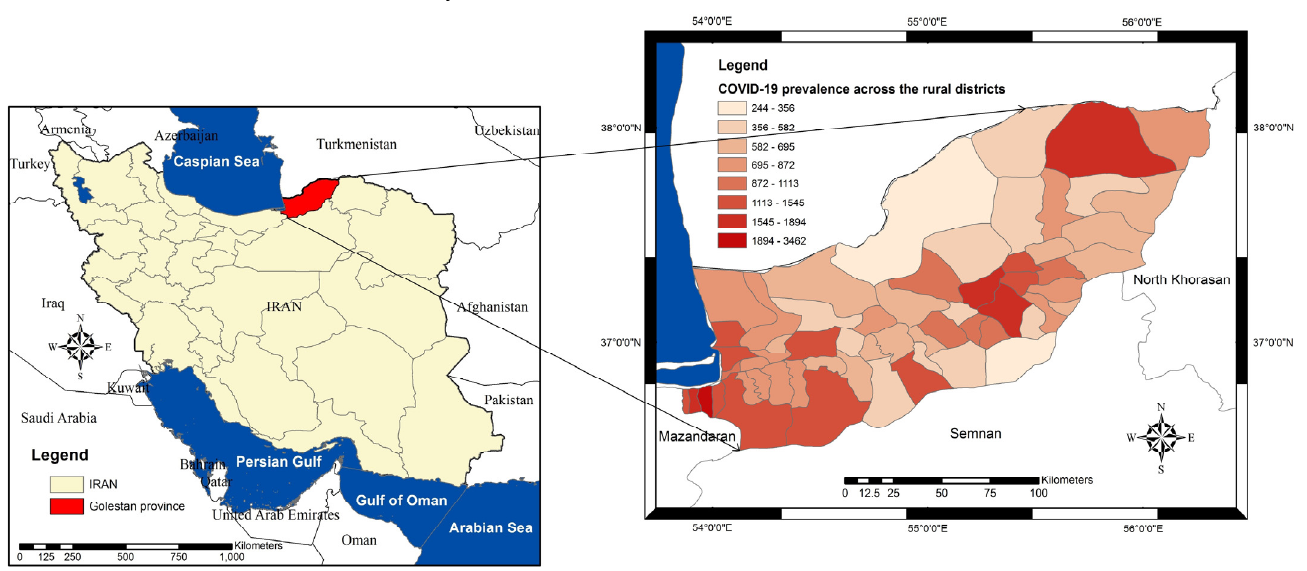
Figure 1. Location of Golestan province and its 60 rural districts.